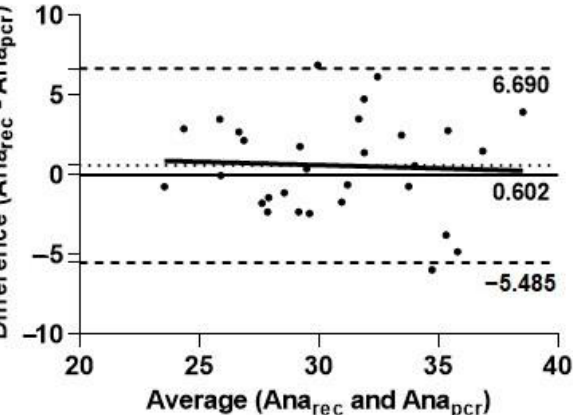
Figure 3. Bland–Altman plot comparing the two anaerobic alactic contribution assessment methods, with black dotted and dashed lines representing the 95% limits of agreement as well as the bias and linear regression (respectively).